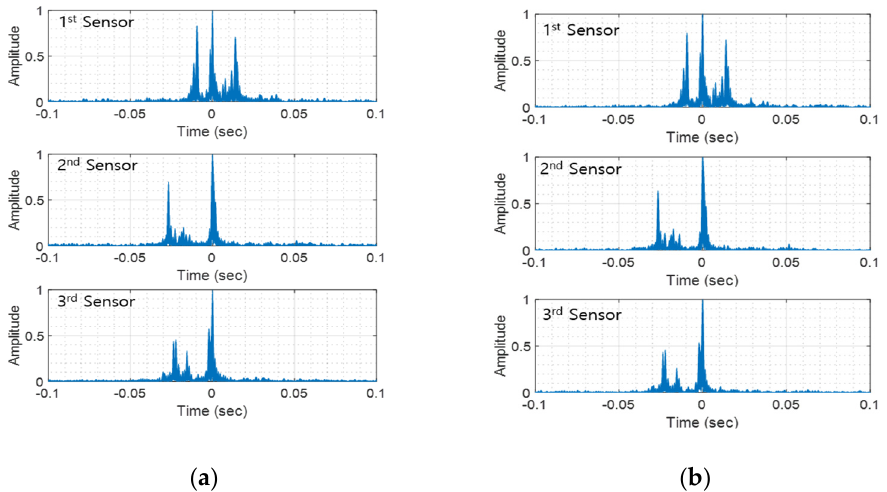
Figure 11. Multipath delay profile of the ocean experiment: ( a ) the proposed method and ( b ) CV-CFM and TFSK.